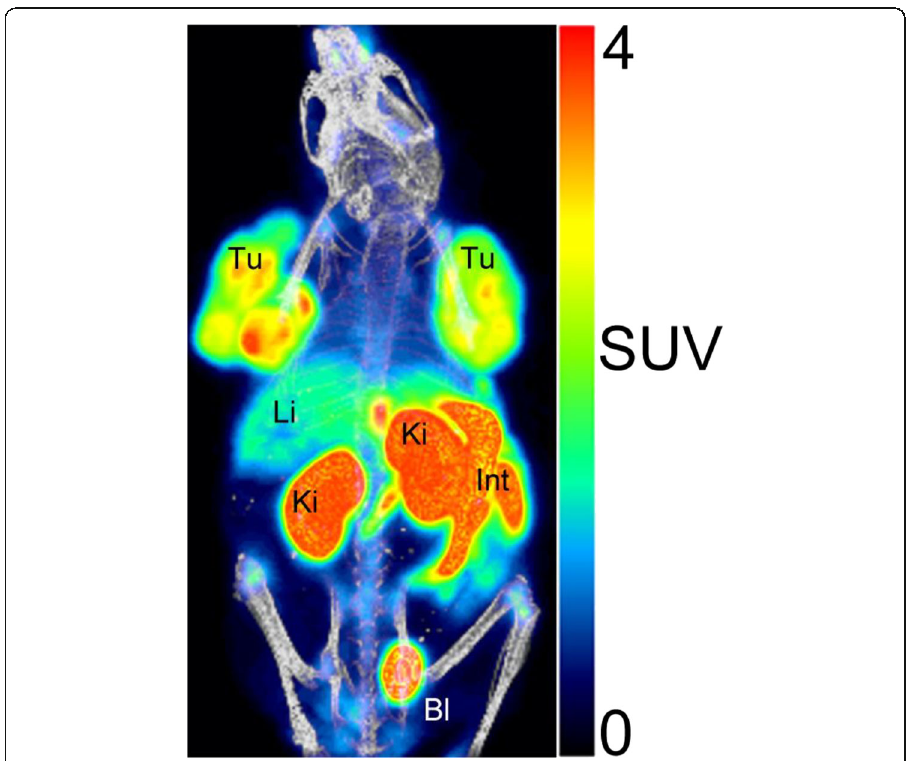
Fig. 2 PET/CT image (three-dimensional, maximum intensity projections (MIP)) of a female CD1 nu/nu mouse. Static scan (whole body, 120 – 150 min p.i.) of CHL-GLP-1 tumor-bearing mouse injected with [ 18 F] 2 (12.7 MBq (1.3 nmol)). Anesthesia was maintained with 2 – 3% isoflurane in O 2 /air. SUV standardized uptake value, Tu tumor, Ki kidneys; Li liver, Bl urinary bladder, Int intestinal